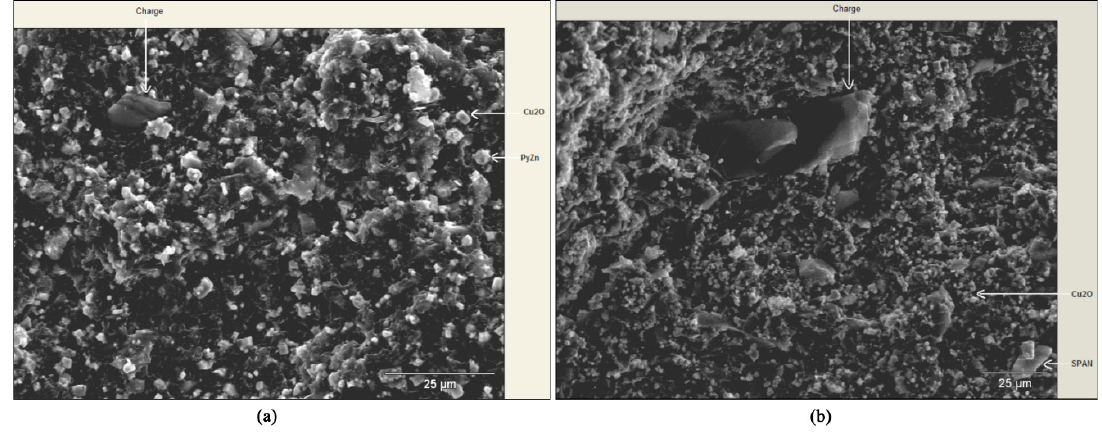
Figure 9. Micrographs of the coatings (a) T1-EMPy; (b) T5-EMSPAN.